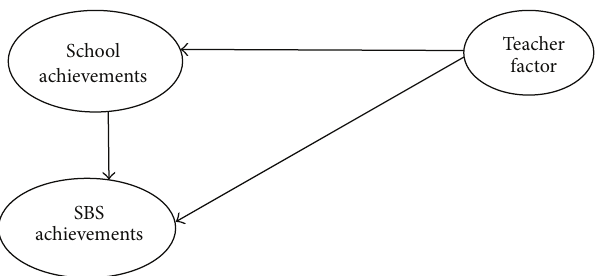
Figure 1: The model showing the effects of teacher factor on students’ mathematics and science achievements in school and